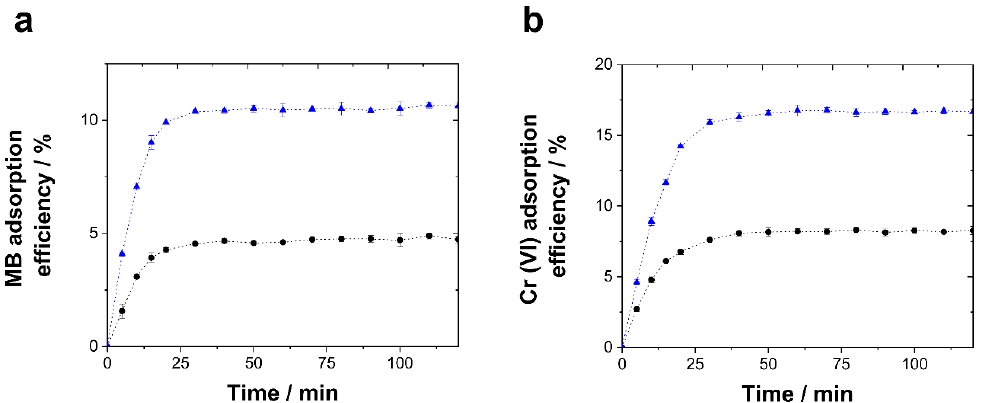
Figure 4. Adsorption efficiency of ( a ) MB and ( b ) Cr(VI) for ( ● ) ZnO and ( ▲ ) ZnO@ZnS(4 h) micro/nanoferns under dark conditions (adsorbent dosage = 0.4 mg mL − 1 , pH = 9.5, and T = 25.0 ± 0.1 °C).